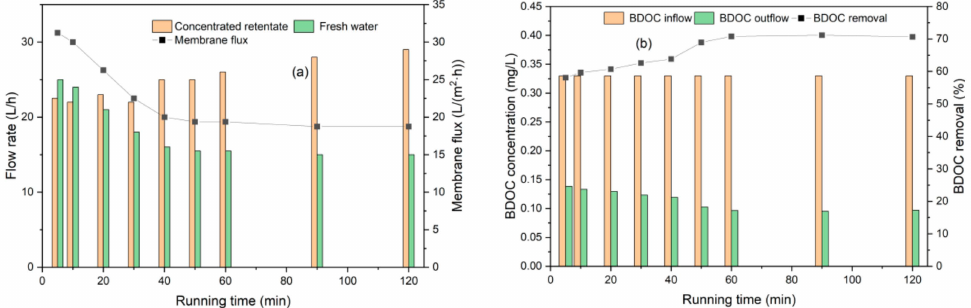
Figure 6. UF performance with time. ( a ) Membrane flux; ( b ) BDOC